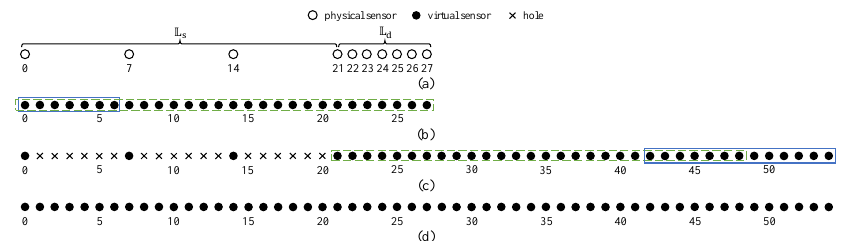
Figure 1. An example of transformed nested array and its coarrays, where N 1 = 4, N 2 = 6. ( a ) Physical array. ( b ) Difference coarray. Green dashed box and blue solid box respectively represent the elements in L d − L s and L d − L d . ( c ) Sum coarray. Green dashed box and blue solid box respectively represent the elements in L d + L s and L d + L d . ( d ) Diff-sum